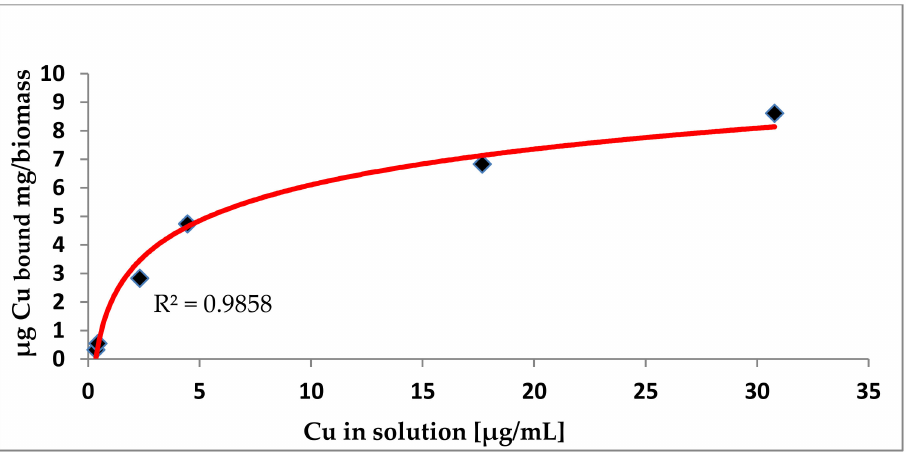
Figure 3. Adsorption isotherm for copper binding by boiled biomass of L. plantarum DSM 20174. Conditions: Deionized water at pH 5.0 with 0.04 to 40 µ g Cu 2 + / mL, biomass concentration 1 mg / mL, and incubation time 30 min. [15,24].